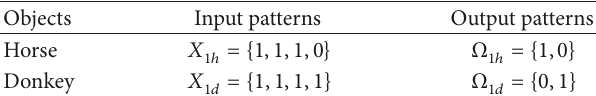
Table 1: Relationships of input/output patterns in